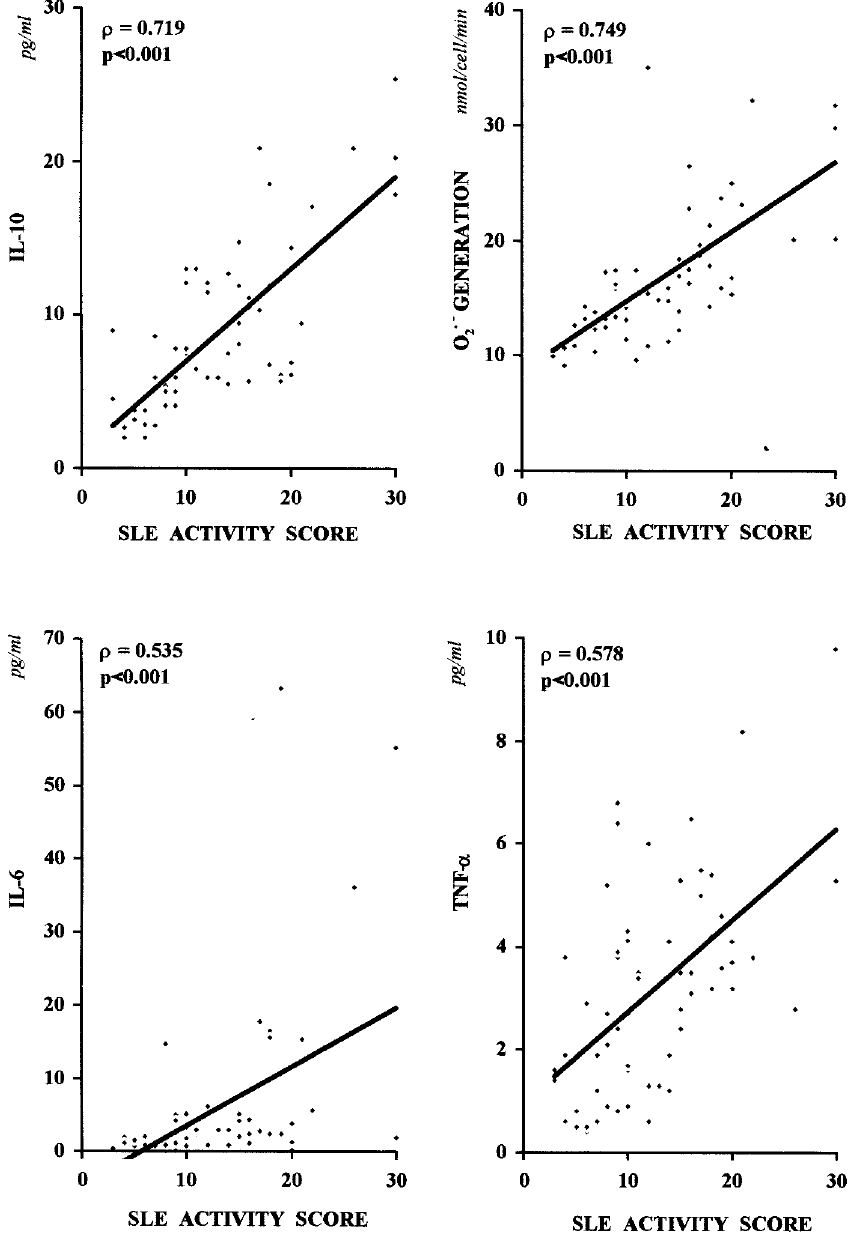
FIG. 1. Correlations between serum level of IL-10, IL-6, TNF- a and generation of O 2.– with SLE